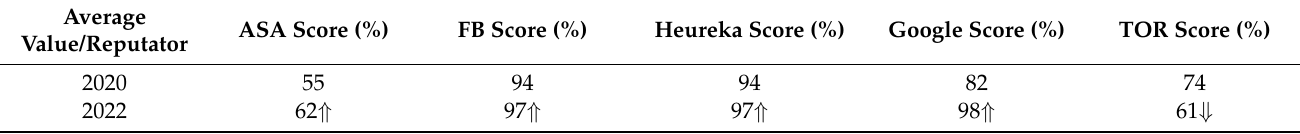
Table 6. Average reputation values across